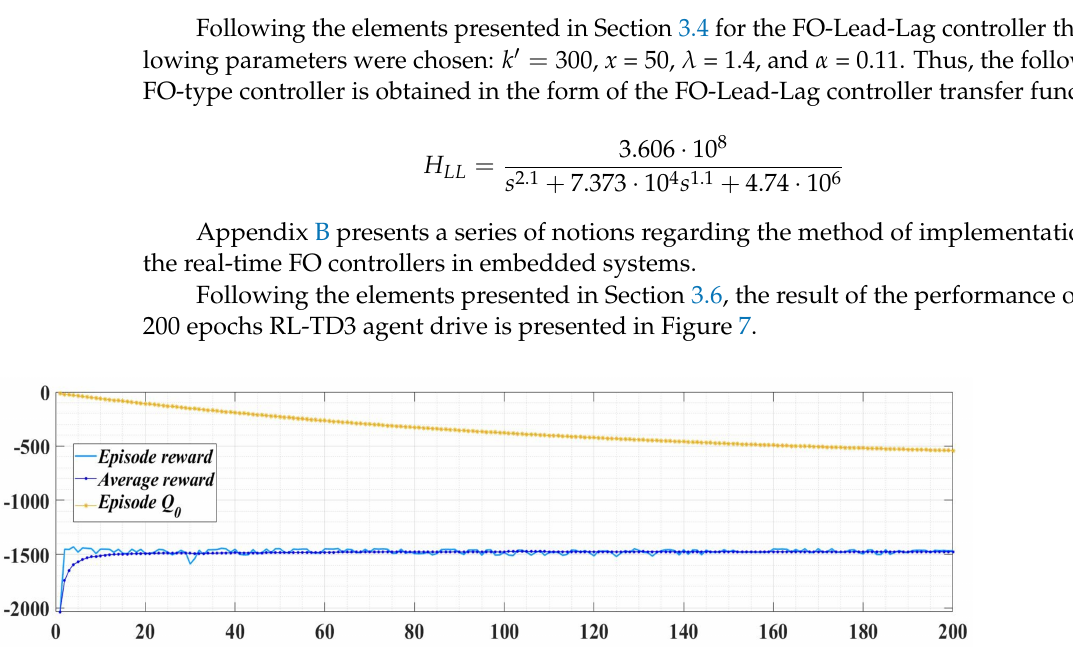
Table 1. Tuned parameters of PI, PI-GWO, and FO-PI controllers.